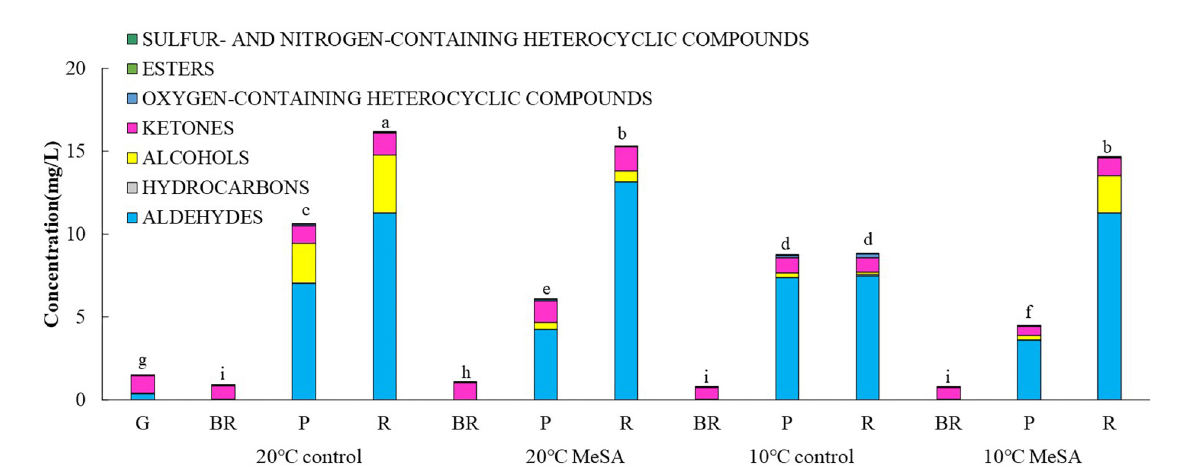
FIGURE1 Effects of methyl salicylate (MeSA) on the contents of different types of volatile compounds in low temperature-treated tomato fruits. Data are expressed as mean ± SD ( n = 3), repeated measures one-way ANOVA followed by Duncan’s multiple range test (DMRT). Data marked with the same letter were no significant difference at p <